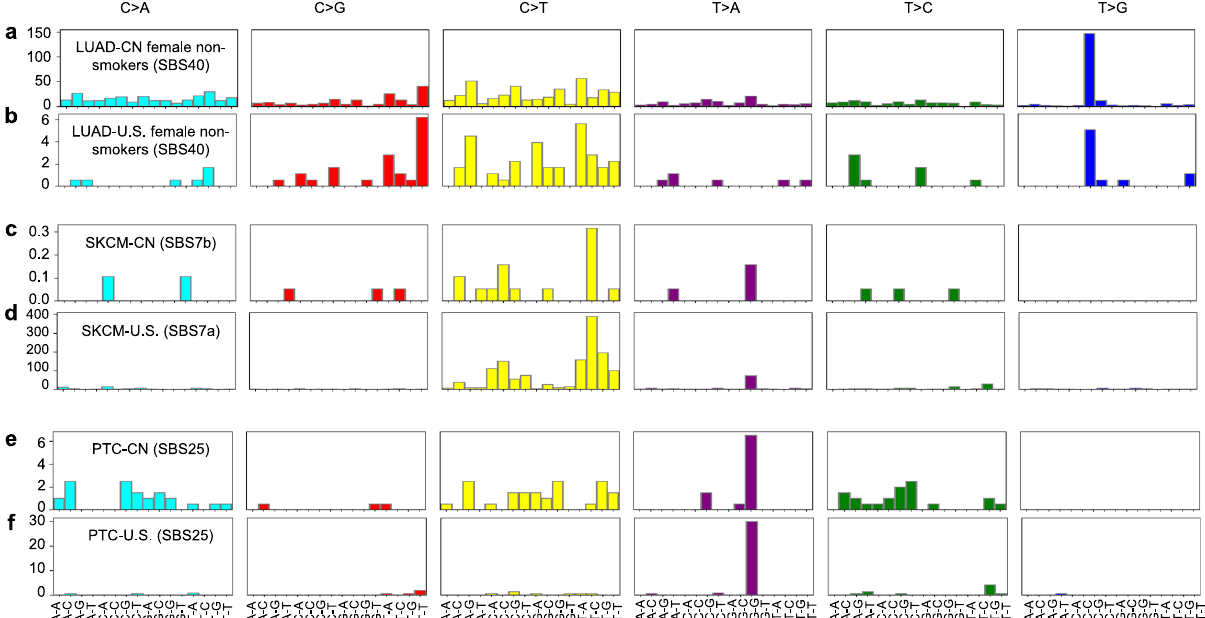
n =225) and papillary thyroid cancer (PTC_CN, n =67; PTC_U.S., n =104) derived from the mutational spectra of the top 50 mutated genes in the Chinese and U.S. patient cohorts, respectively. Source data for mutational signature analysis are provided in Supplementary Software